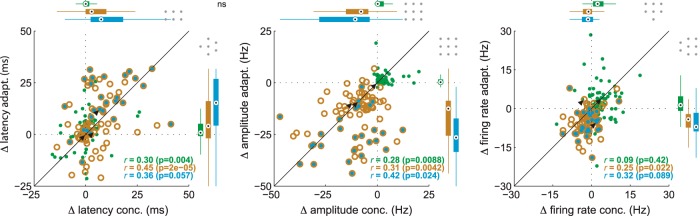
Correlated changes in response features for concentration and adaptation. From left to right, plots show changes in the latency, amplitude, and mean firing rate. Points are individual response sets. Response types are indicated by color as in Figure 1. Box plots show distributions of response changes across cells for concentration and adaptation. Conventions are as in Figure 1. Reported r values are Spearman correlation coefficients computed independently for the three response types. Black arrows mark positions of the three example cells in Figures 1 and 2.